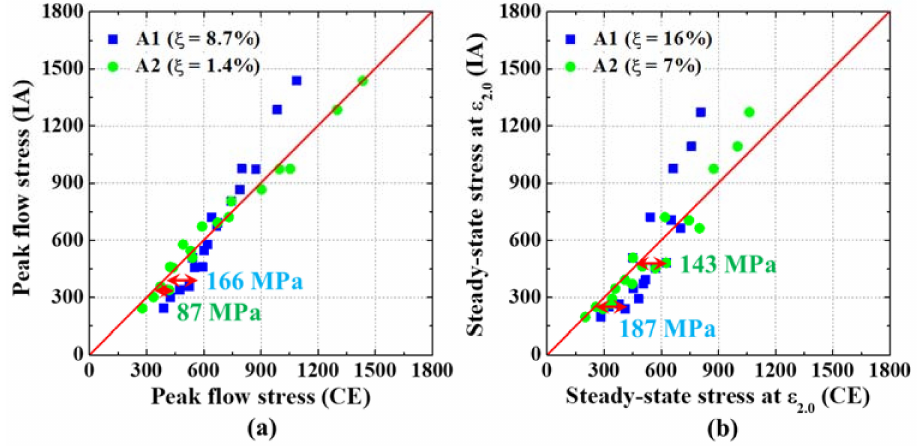
Figure 11. Flow stress correlation between IA and CEs calculated using temperature sensitivities A 1 and A 2: ( a ) peak flow stress and ( b ) steady-state stress at ε 2.0